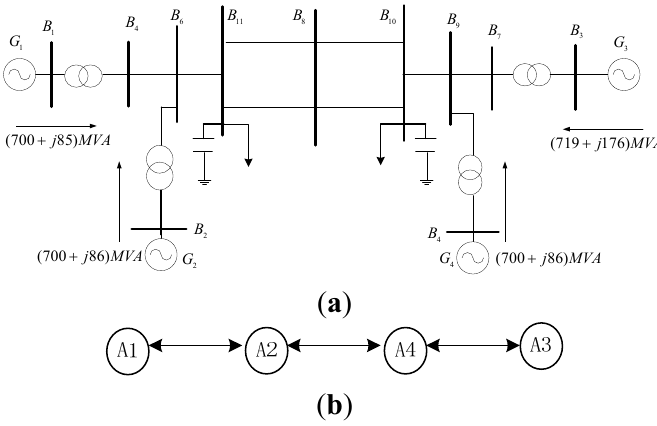
Figure 1. Two-area four-machine system. ( a ) Single line diagram; ( b ) The topology of communication